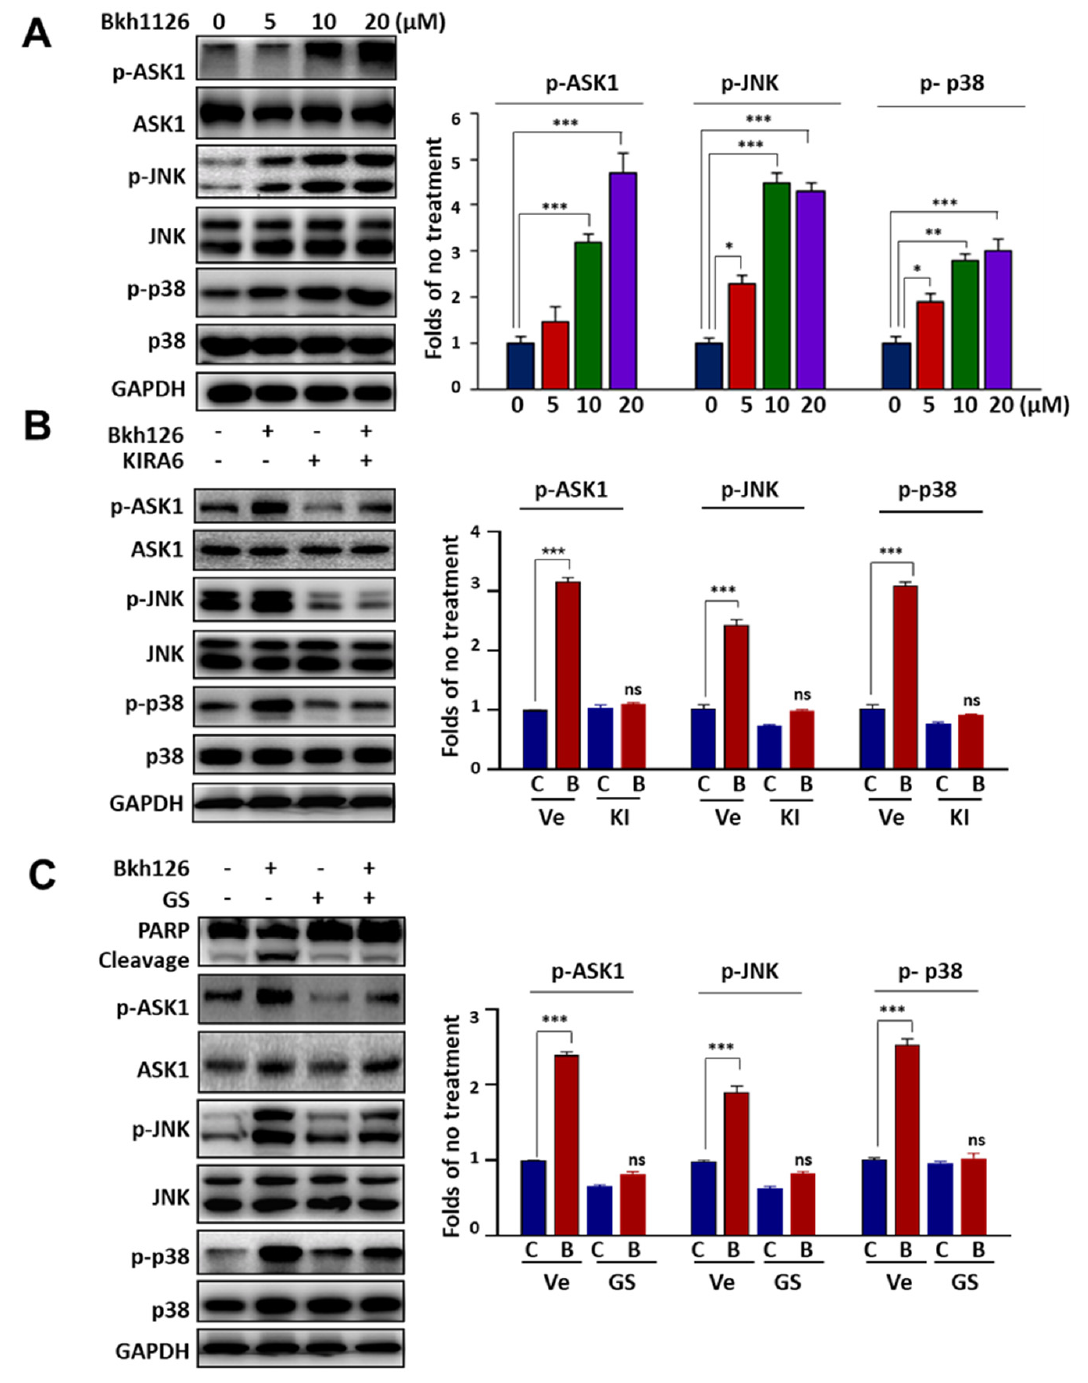
Figure 3. Bkh126 induces IRE1 α -ASK1 activation and apoptosis: ( A ) HepG2 cells were treated with increasing concentrations of Bkh126 for 24 h. The cells were lysed and blotted with antibodies against total and phosphorylated proteins of ASK1, JNK, and p38. The protein levels were quantified based on the blot gray intensities. ( B , C ) HepG2 cells were pre-treated with 5 µ M KIRA6 (IRE1 α inhibitor) ( B ) or 1 µ M GSK-444217 (ASK1 inhibitor) ( C ) and then 20 µ M Bkh126 for 24 h. The protein expression and phosphorylation of ASK1, JNK, and p38 were blotted. The cleavages of PARP were compared among groups. * p < 0.05, ** p < 0.01, and *** p < 0.001. C, control; B, Bkh126; Ve, vehicle; KI, KIR6; GS, GS ‐ 444217.